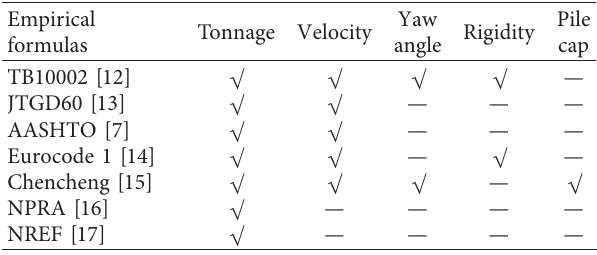
Table 1: Comparison of factors considered in various models. Empirical formulas